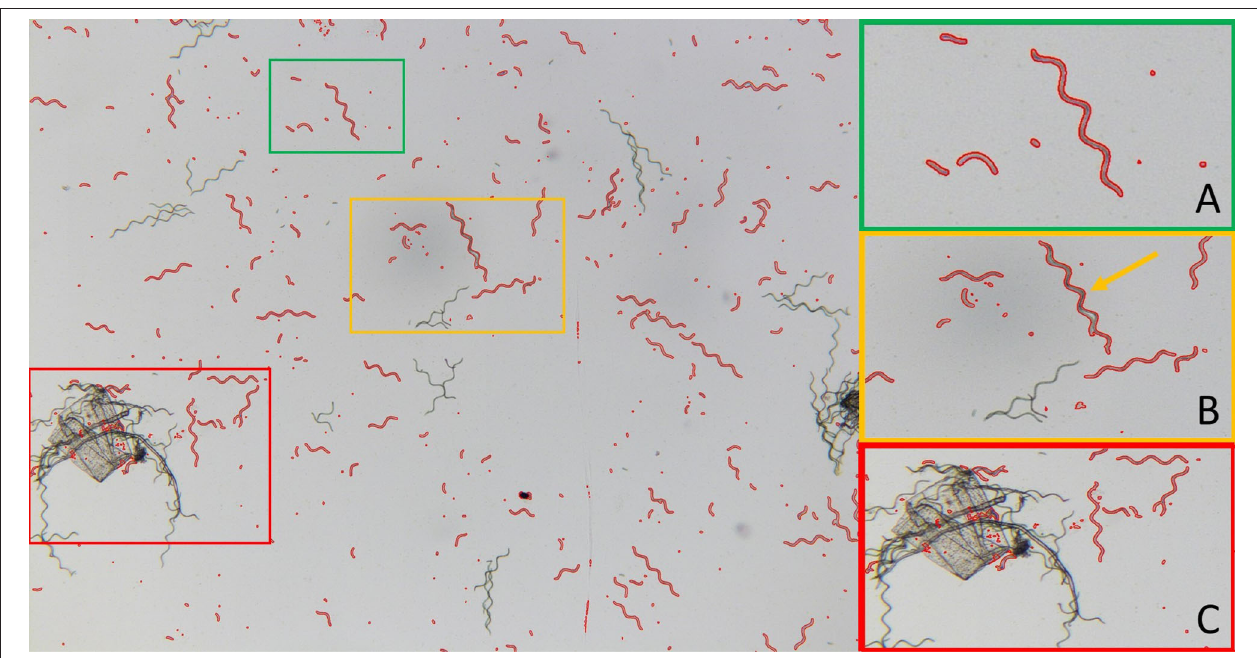
FIGURE 7 | Example image for particle size detection (10 kV cm − 1 , 60min). Subframe (A) example of successful detection of A. platensis trichomes and fragments of different size classes. Subframe (B) example of false detection of two A. platensis trichomes that are nested together and detected as one particle (cf. yellow arrow). Subframe (C) example of false detections due to